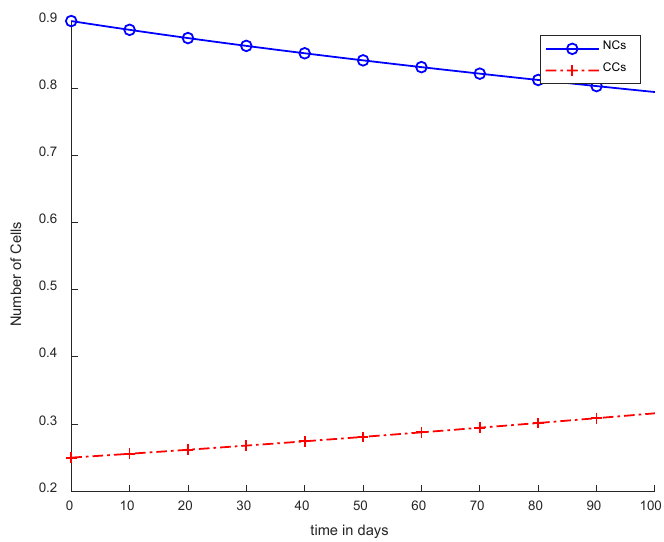
comparison with normal cells. During experimentation, the initial value of CCs was 0.25. Figure 2. Behavior of constant and continuous chemotherapy. Therefore, 0.25 is considered the threshold for cancer patients. If the value of CCs is increased from 0.25, then the patient will die on the spot.